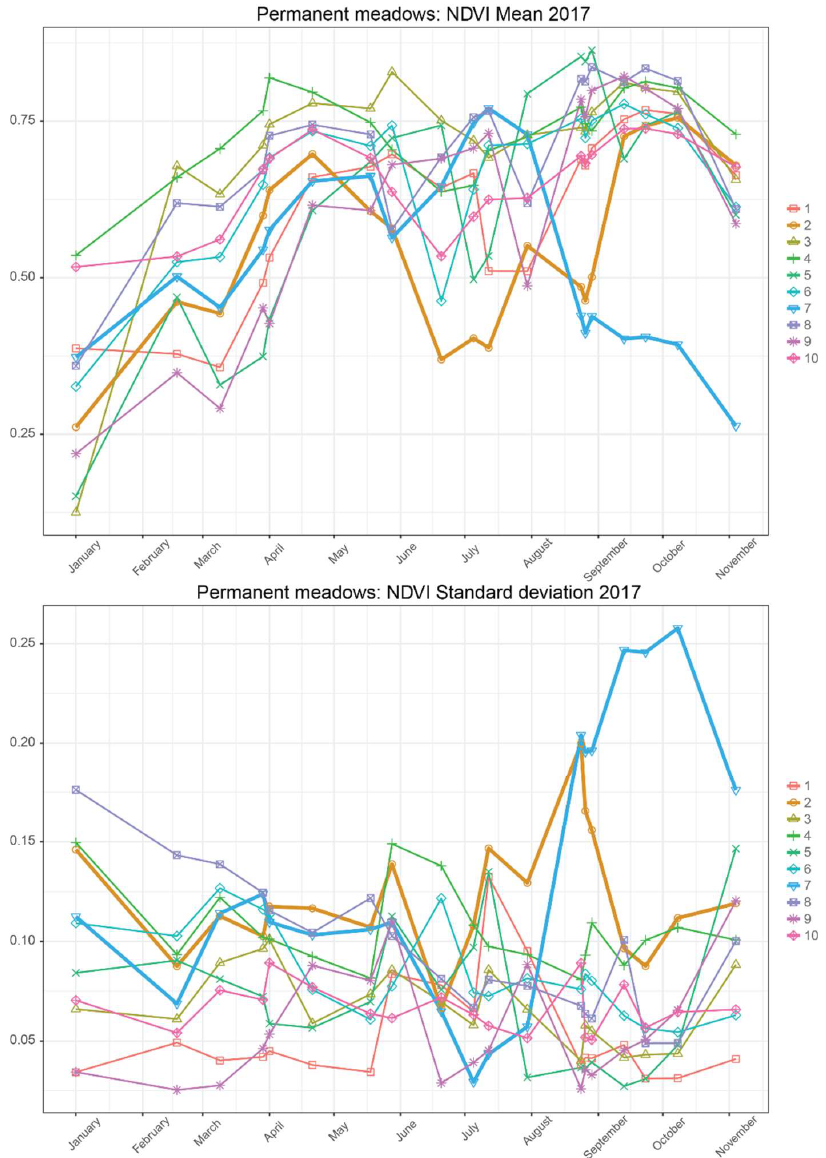
Figure 7. The temporal graph (NDVI development curve) of the selected ten permanent meadows in Duplek area shows the trajectories of mean and standard deviation values. The irregular behaviors of two permanent meadows objects are highlighted as thicker lines (objects 2 and 7).